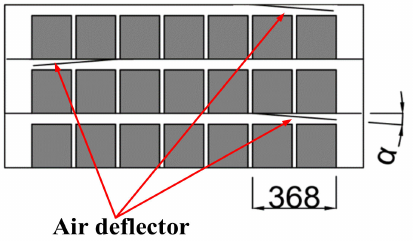
Figure 16. Schematic diagram of lengthened deflectors in the battery